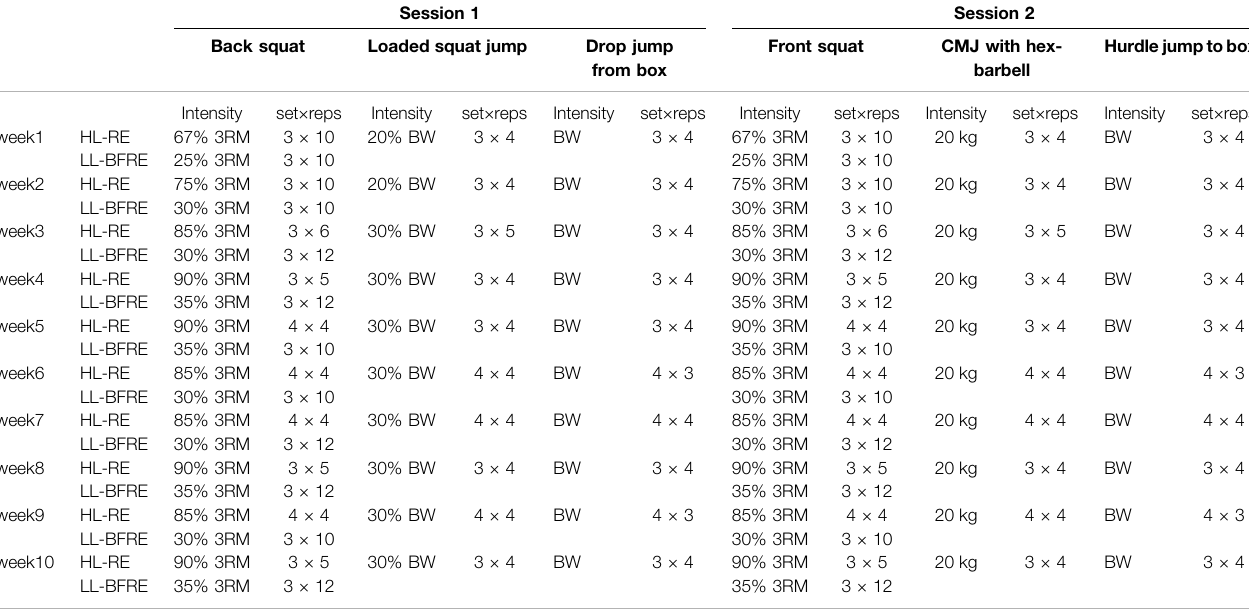
TABLE 1 | Training program of HL-RE and LL-BFRE groups. Session 1 Session 2 Back squat Loaded squat jump Drop jump from